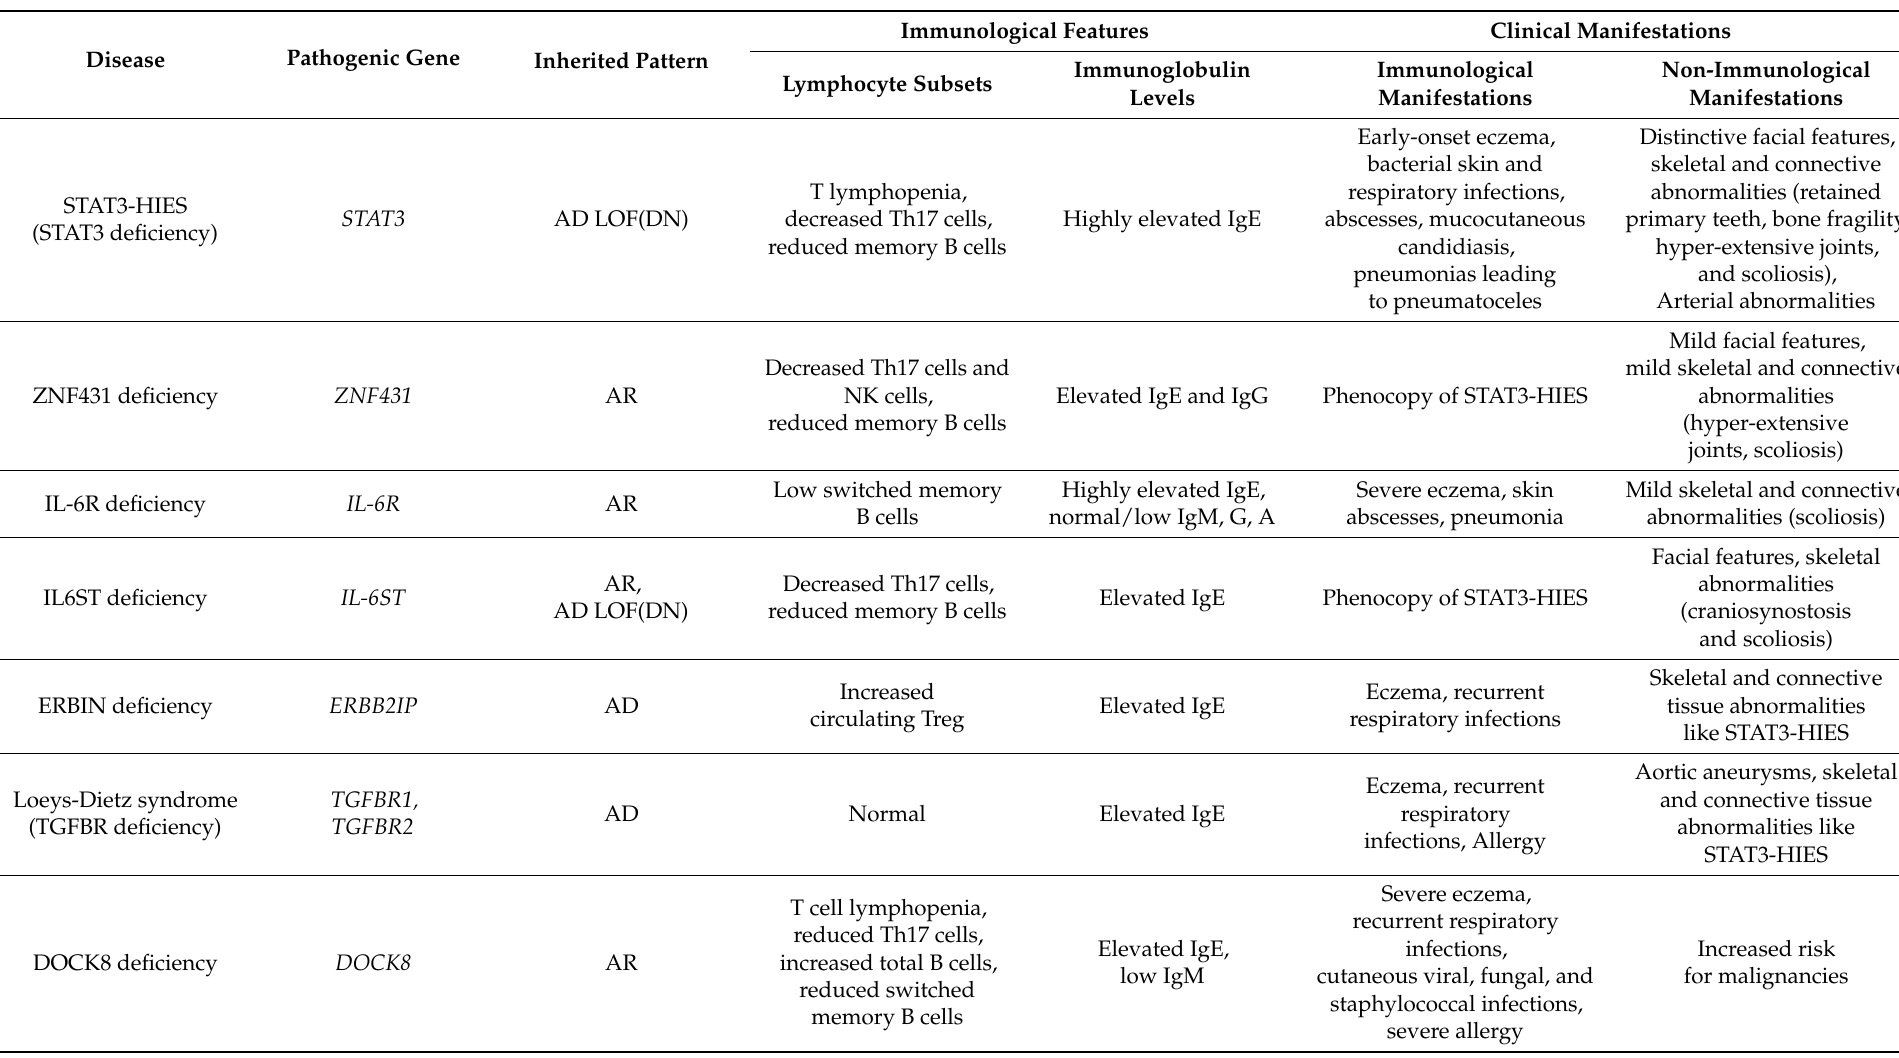
Table 1. The genetic and clinical spectrums of hyper IgE